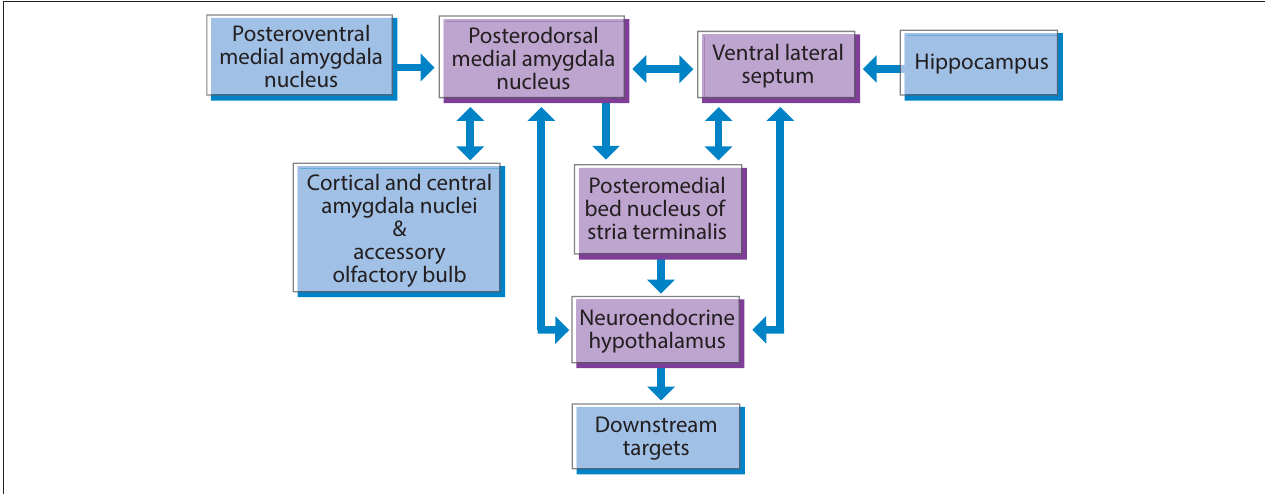
FIGURE 3 | Nkx2-1 is expressed in a subcortical neuroendocrine network involved in social behavior and reproduction in the rodent brain. The posterodorsal medial amygdala, ventral lateral septum, and posteromedial bed nucleus of the stria terminalis, provide major inputs to the hypothalamic neuroendocrine effector system. Neuroendocrine hypothalamic nuclei provide feedback to the posterodorsal medial amygdala, and the ventral lateral septum.